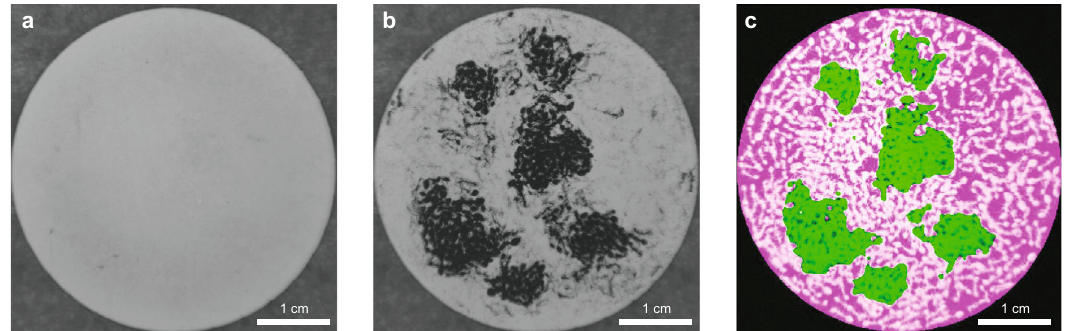
Fig.9|Densityanalysis.a Themaximumprojectionforeachpixeloverthecourse ofanexperimentwith N =625ants. b Themaximumprojectionforeachpixelinthe 30sfollowingtheimageshowninFig.8b. c Acompositeimageshowingtheresults